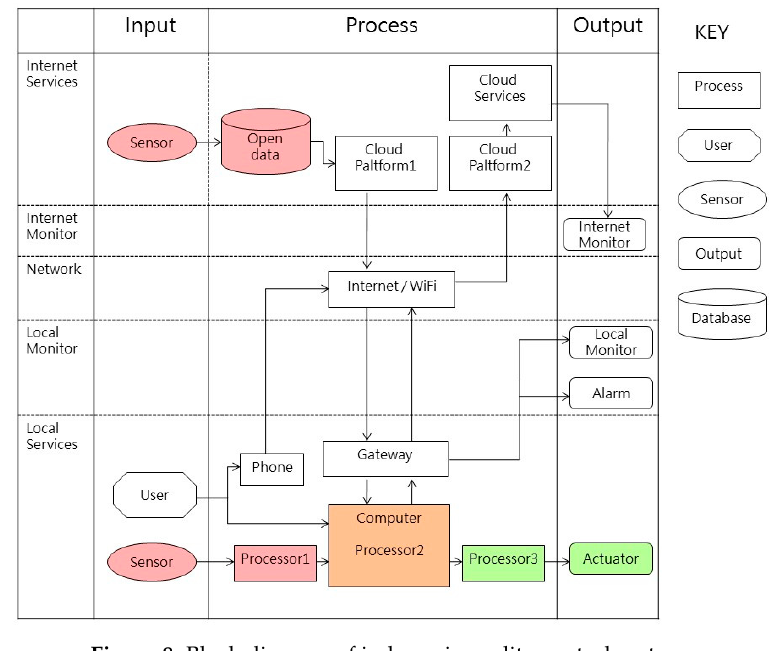
Figure 8. Block diagram of indoor air quality control system.